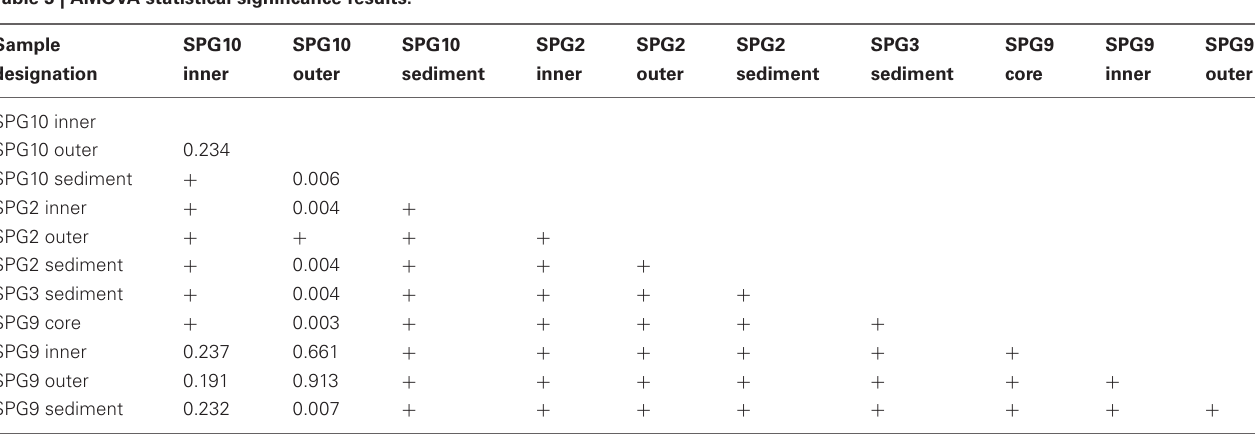
Table 3 | AMOVA statistical significance